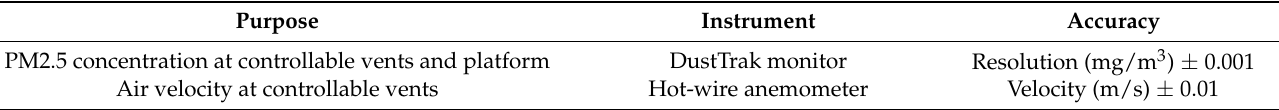
Table 2. Details of the instruments used in the field